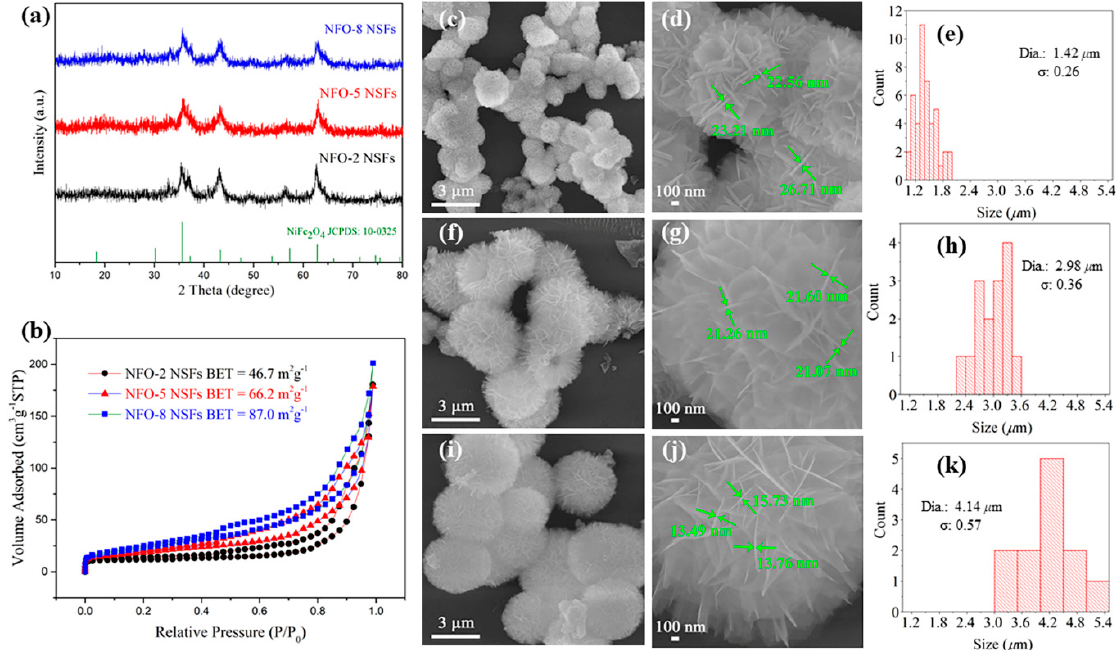
Figure 1. The XRD patterns ( a ) and nitrogen adsorption–desorption isotherms and Brunner–Emmet–Teller (BET) surface area values ( b ) of NFO-2, NFO-5 and NFO-8 nanosheet-assembled flowers (NSFs); SEM images and flower size distribution of NFO-2 NSFs ( c – e ), NFO-5 NSFs ( f – h ) and NFO-8 NSFs ( i – k ).